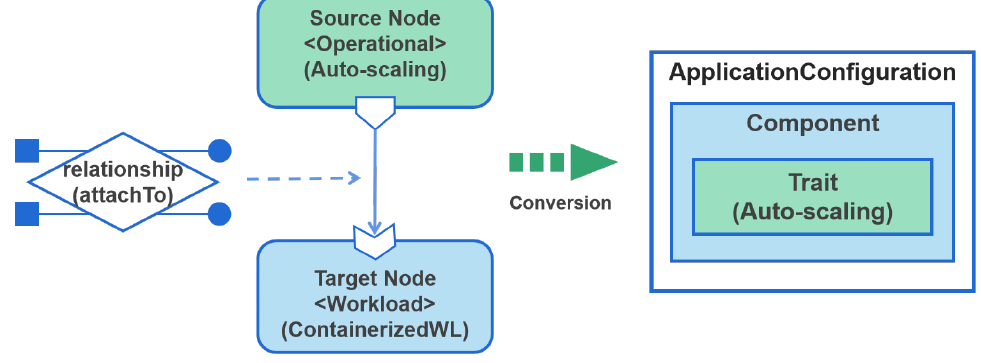
Figure 7. Conversion of AttachesTo Relationship.